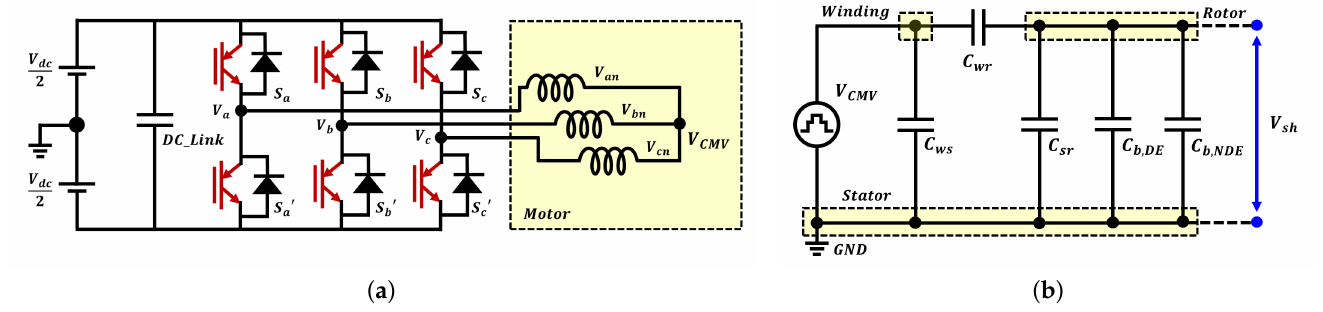
Figure 13. Circuit configuration of driver system and parasitic capacitance. ( a ) Typical PWM inverter; ( b ) parasitic capacitance circuit for shaft voltage analysis.